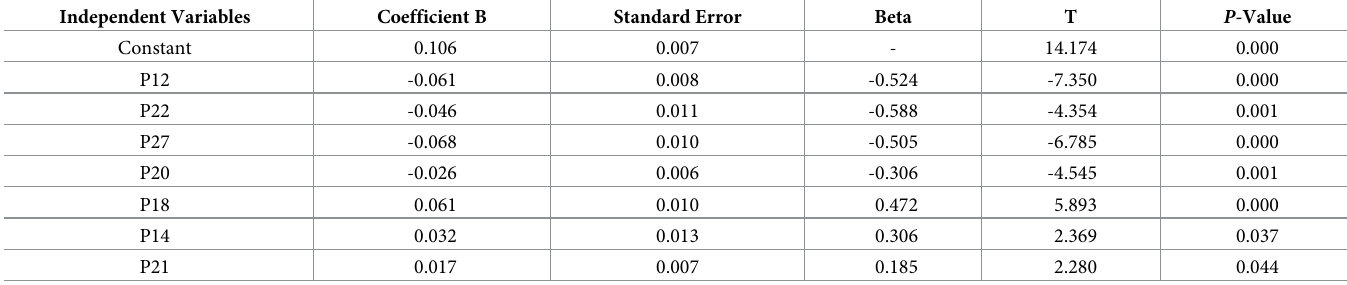
Table 8. Summary of model variables for cost performance in reconstruction projects. Independent